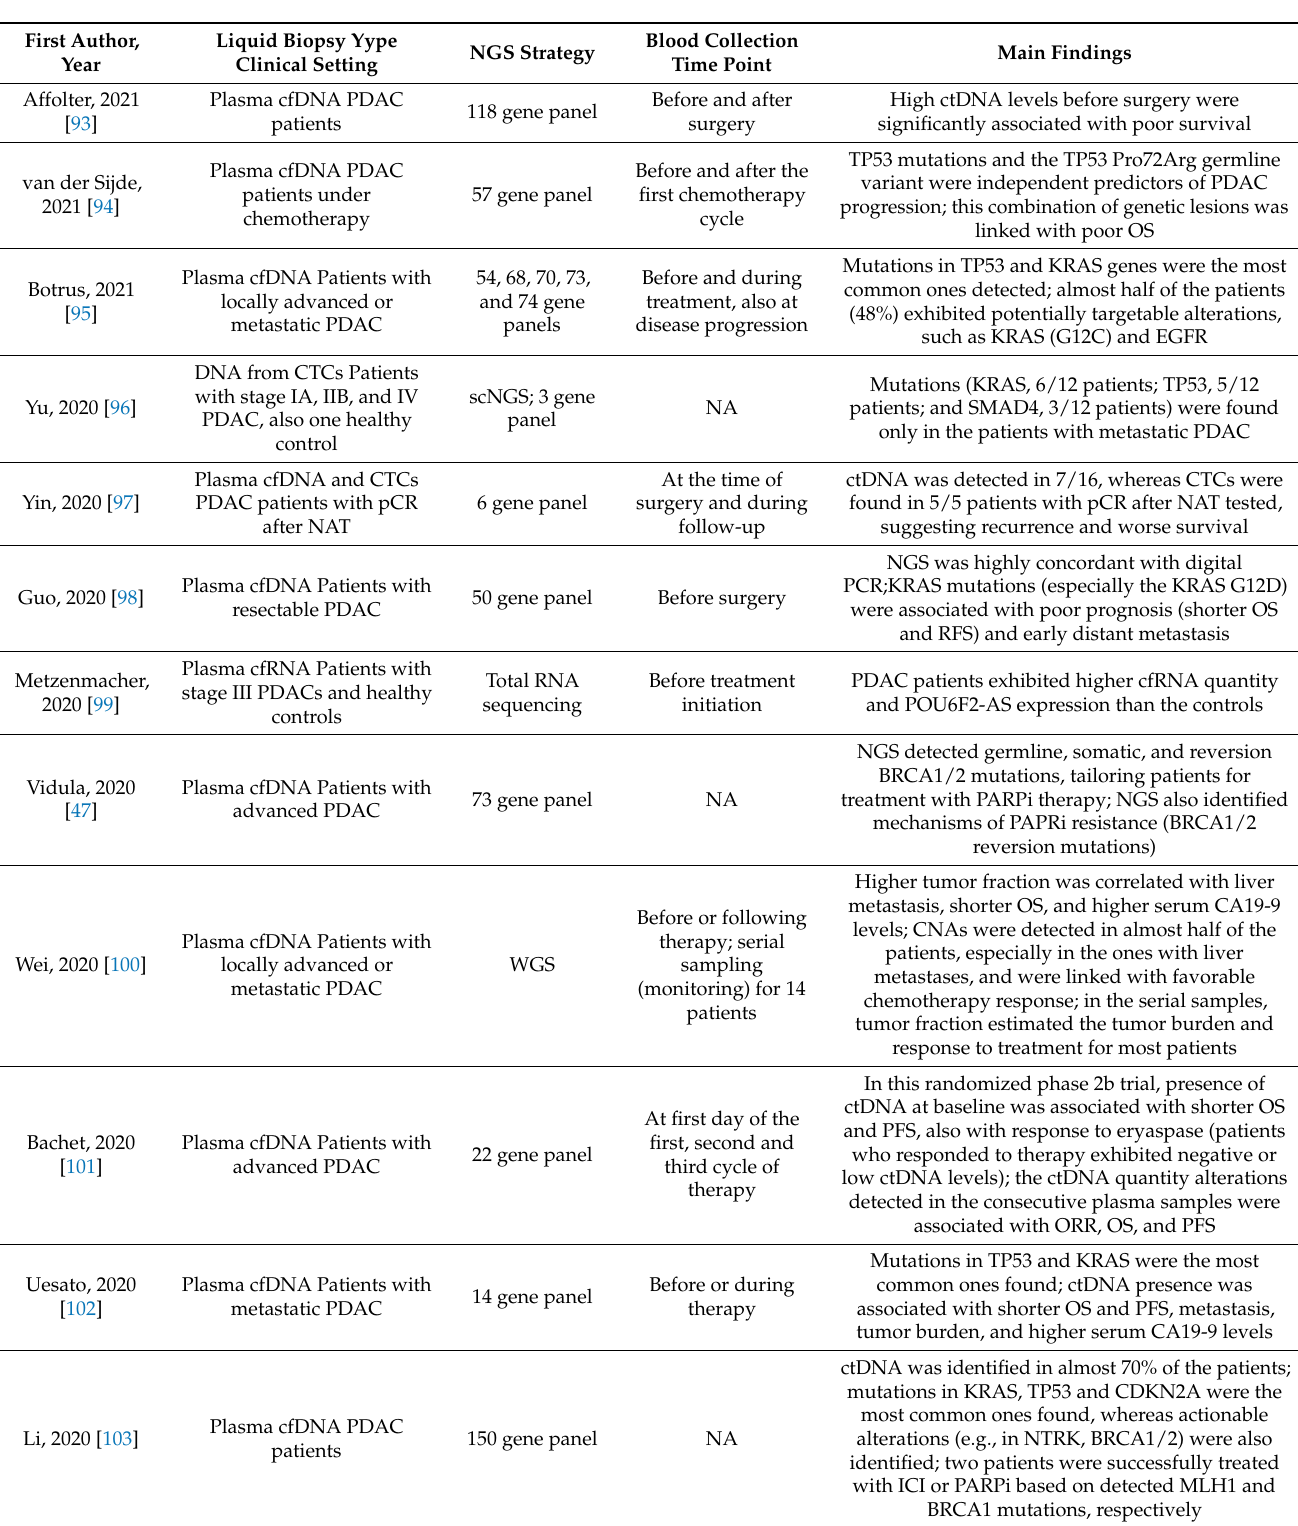
Table 3. The role of blood liquid biopsy-based NGS in the evaluation of pancreatobiliary lesions: doing more with